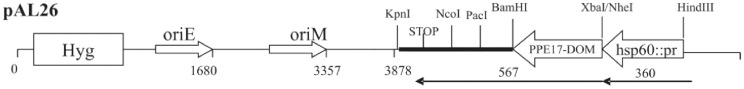
Map of pAL26.Shuttle expression vector designed to facilitate the expression of chimeric proteins fused to the PPE domain of PPE17.